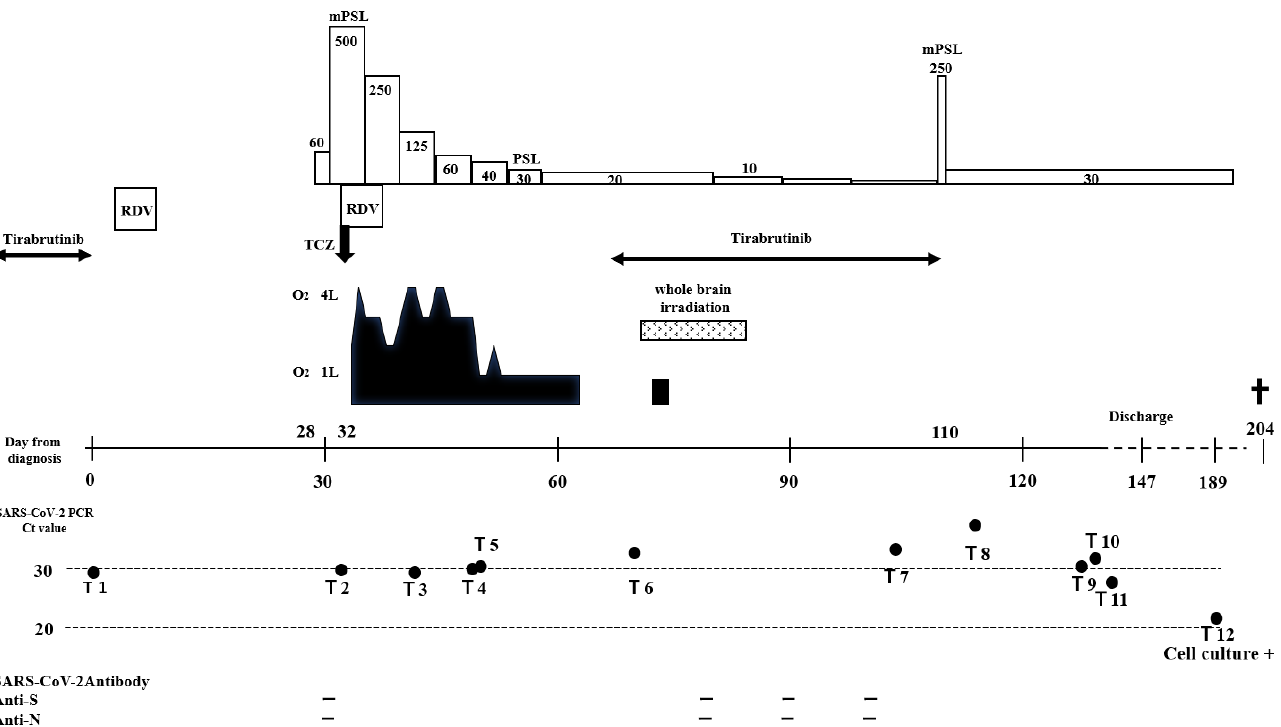
Figure 1. The clinical course of the patient and the time course of the levels of SARS-CoV-2 viral RNA and the results of antibody testing. SARS-CoV-2: severe acute respiratory syndrome coronavirus 2; RDV: remdesivir; TCZ: tocilizumab; mPSL: methylprednisolone; PSL: prednisolone; Ct: cycle threshold, Anti-S; antibody spike protein; Anti-N, antibody nucleocapsid protein.